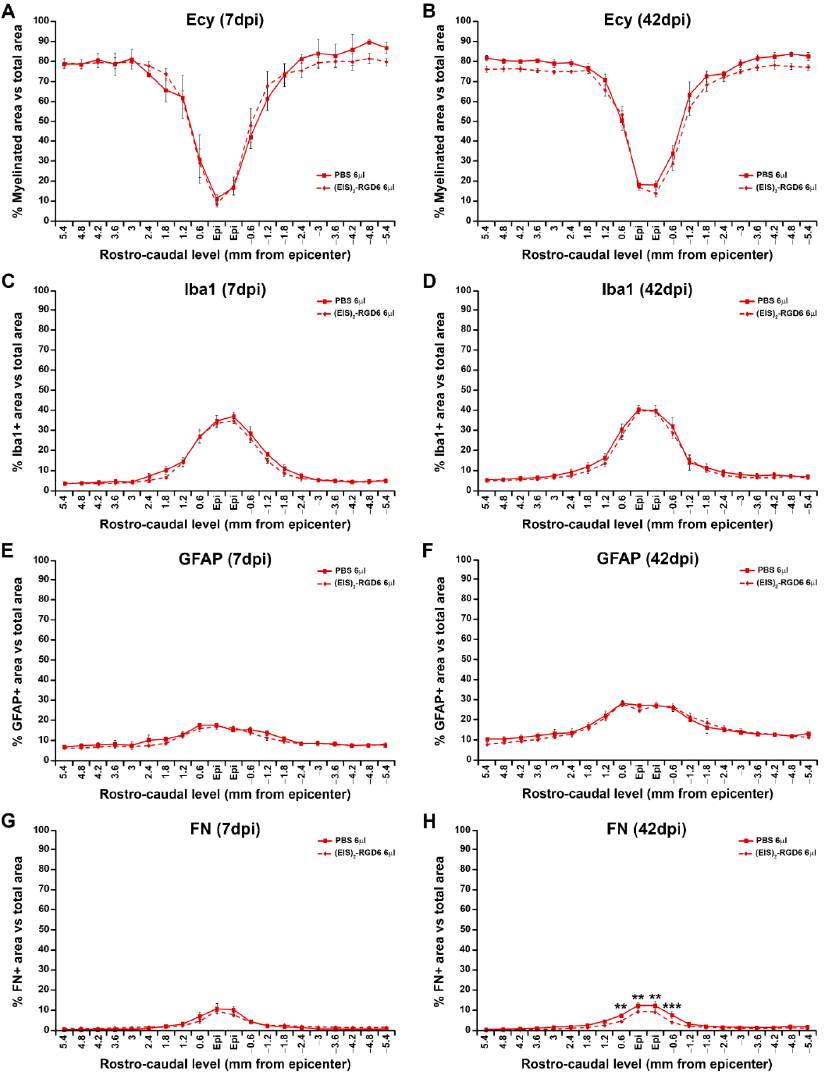
Figure 16. Analysis of the effects exerted by (EIS) 2 -RGD6 injection in myelin preservation, fibrosis, and microglia/macrophage and astroglial reactivity. Graphs show data obtained from the densito- metric quantification of ( A , B ) myelin preservation [eriochrome cyanine (Ecy) staining]; ( C , D ) mi- croglia/macrophage reactivity [ionized calcium-binding adaptor molecule 1 (Iba1) immunostain- ing]; ( E , F ) astroglial reactivity [glial fibrillary acidic protein (GFAP) immunostaining]; and ( G , H ) fibrosis [fibronectin (FN) immunostaining]. **, p < 0.01 and ***, p < 0.001 PBS 6 µL group vs. (EIS) 2 -RGD6 at 7 ( A , C , E , G ) and 42 days post-injury (dpi) ( B , D , F , H ) in animals used to perform experiment (EIS) 2 -RGD6 III. Please note that representative images from Ecy, Iba1, GFAP, and FN stained sec- tions can be found in Figures 17–20, respectively.